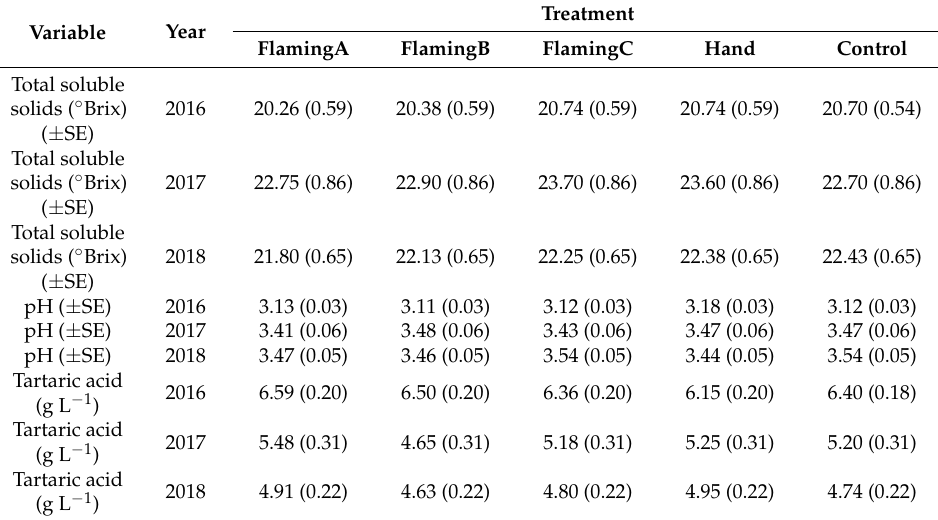
Table 6. Least-squares means and standard errors of the total soluble solids, pH, and tartaric acid as affected by the type of treatment and the year.